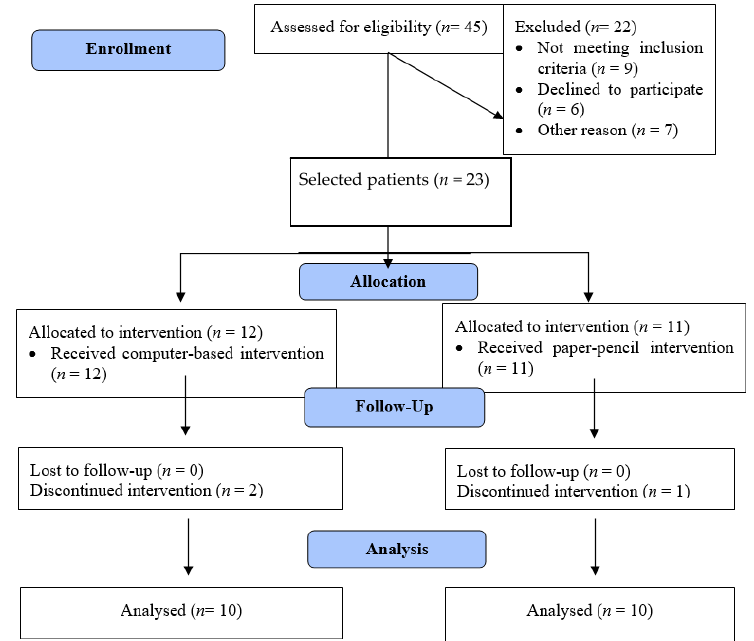
Figure 1. Participants’ flow diagram.